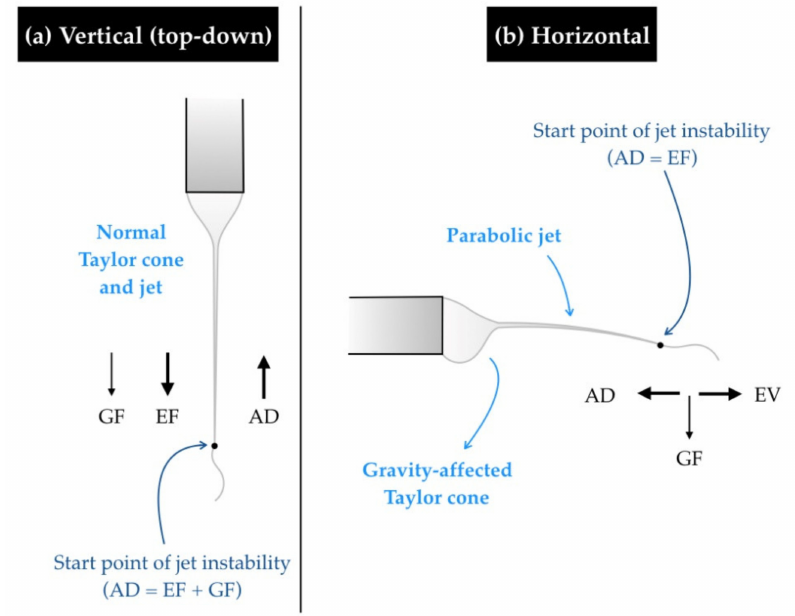
Figure 3. Taylor cone distortion and parabolic jet in horizontal electrospinning. (GF—gravity, EF—electric field, AD—aerodynamic drag). ( a ) The Taylor cone is undisturbed in the vertical orientation because GF and EF act in the same direction (top-down). ( b ) Gravity-a ff ected Taylor cones and parabolic jets, asdepicted, arecommonlyobservedinthehorizontalorientation. Here, GFandEFactperpendicular to each